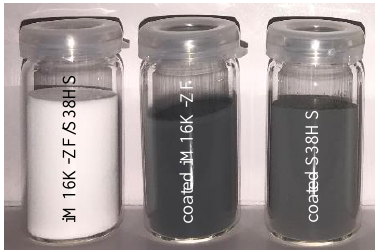
Figure 7. Qualitative verification of the coating of the MHGS with Setup 2: The original spheres have a white color, the coated spheres show a gray coloration.